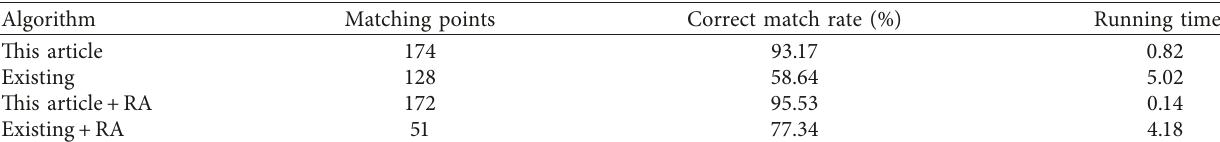
Figure 5: Matching experimental results. Table 1: Comparison of matching